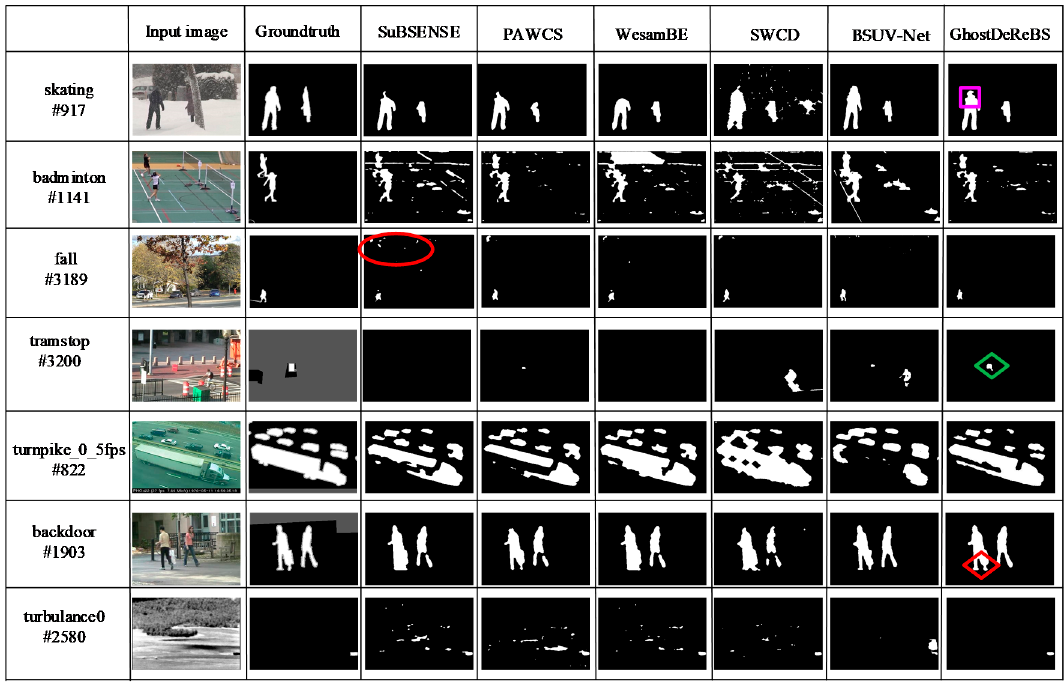
Figure 9. Some segmentation results for various video sequences on the CDnet 2014 dataset.